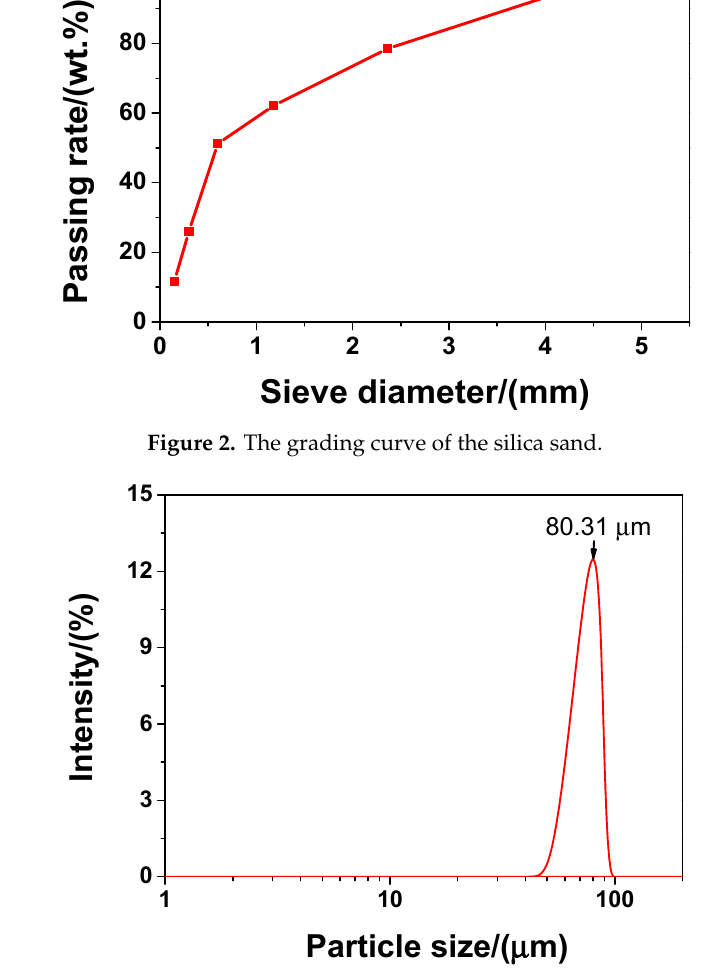
Figure 3. The actual particle size of the GSNSs suspension via dynamic light scattering test.